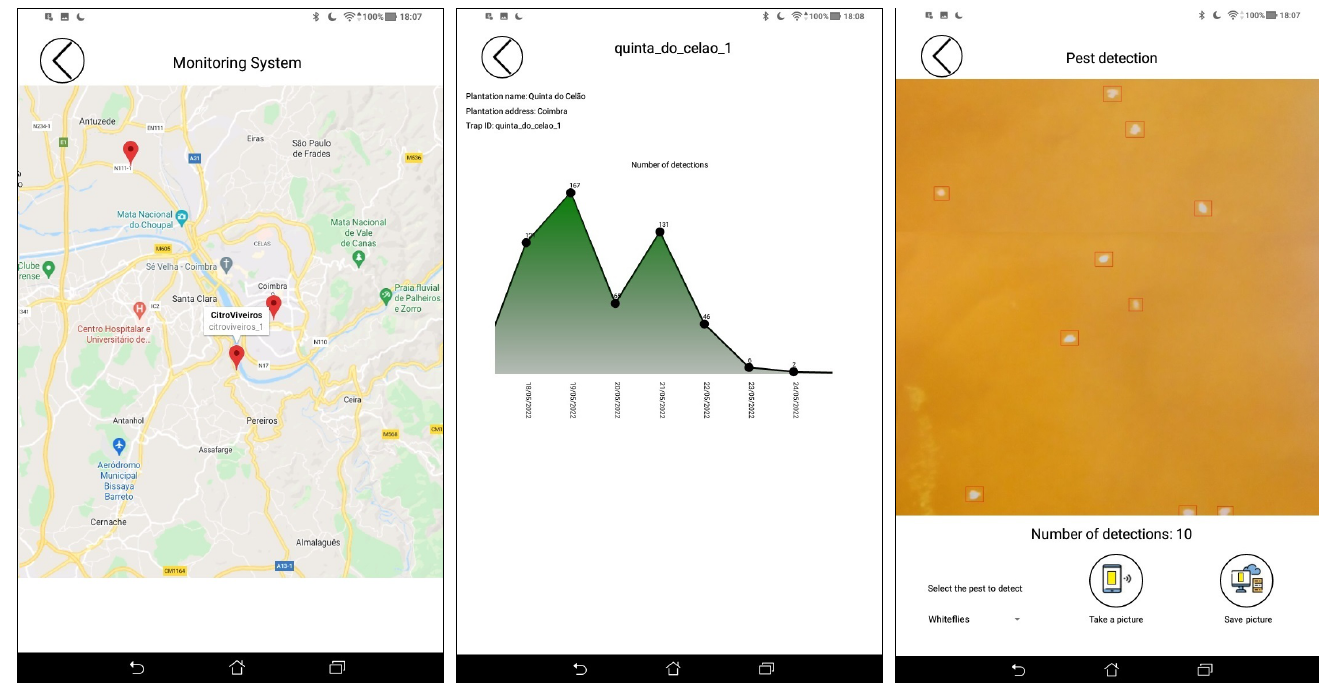
Figure 11. Part of the mobile app that allows users to monitor